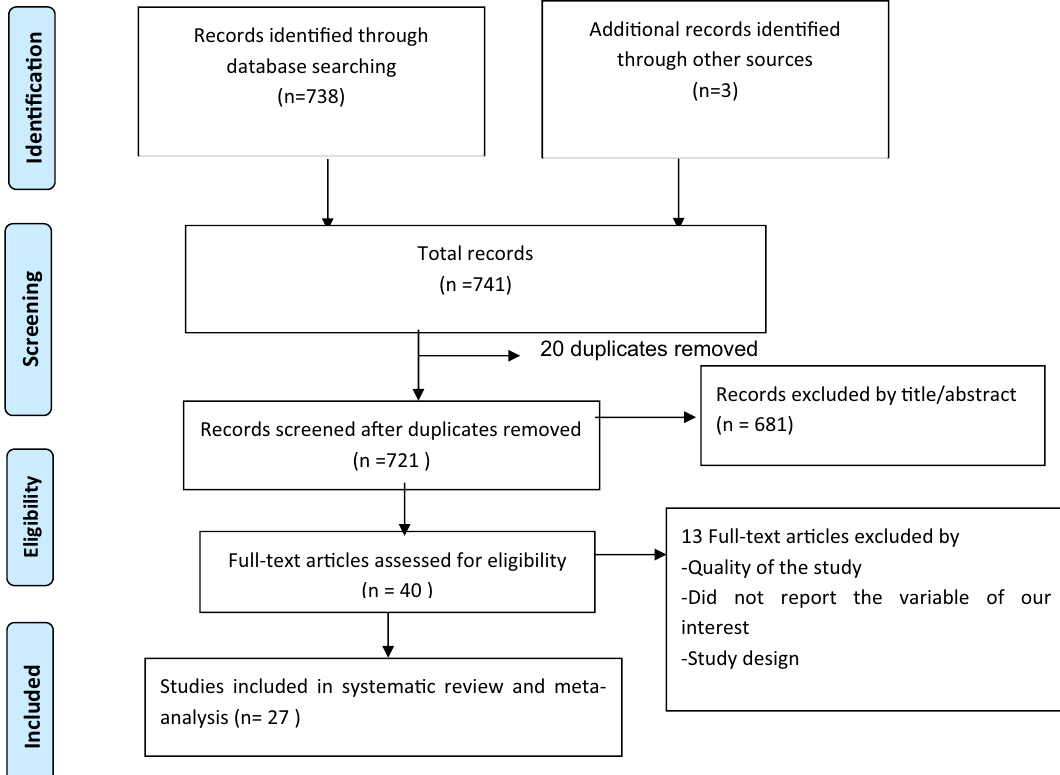
Figure 1. PRISMA flow diagram of studies included to estimate the effect of ANC follow up on ENBC practice in East Africa in the systematic review and